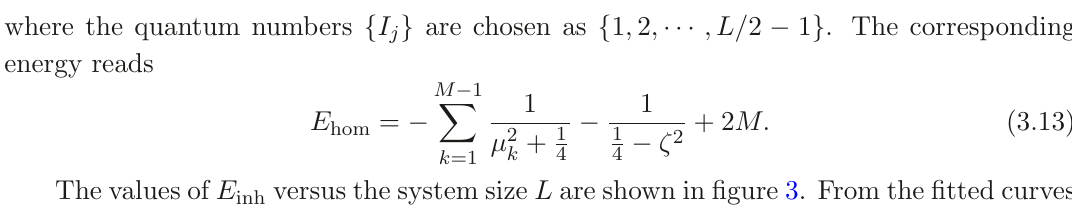
Figure 3. The values of E inh versus the system size L . The data can be fitted as E inh = ˜ γL ln( | E inh | ) = ˜ p ln( L ) + ˜ q ]. Here ξ = − 0 . 1, ξ ′ = 0 . 95, θ = 0 . 15, φ = φ ′ = 0, (a) θ ′ = 0 . 80, ˜ γ = 0 . 0423 and ˜ β = − 1 . 0250; (b) θ ′ = 1 . 20, ˜ γ = 0 . 1097 and ˜ β = − 1 . 0260; (c) θ ′ = 1 . 57, ˜ γ = 0 . 1988 and ˜ β = − 1 . 0250. Due to the fact ˜ β < 0 [or ˜ p < 0], when the L tends to infinity, the E